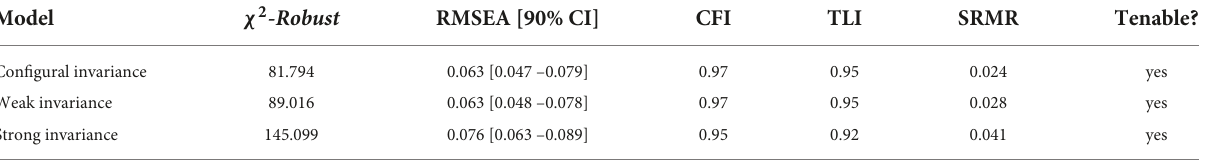
TABLE 3b Fit indices for the configural, weak, and strong invariance model. Model χ 2